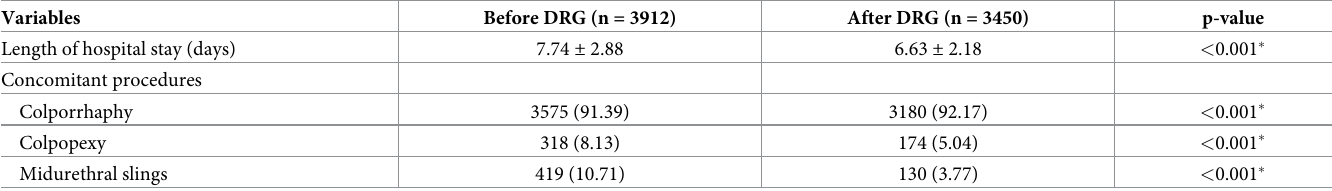
Table 3. Changes in the length of hospital stay and concomitant procedures after the introduction of diagnosis-related group payment system.